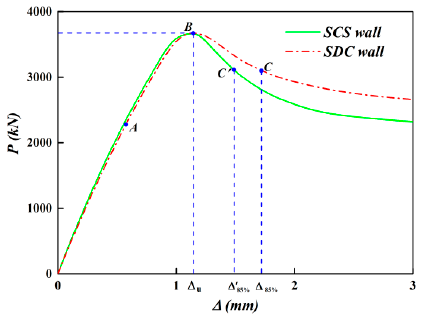
Figure 11. P- ∆ curves of the SCS wall and SDC Figure 11. P - ∆ curves of the SCS wall and SDC wall.